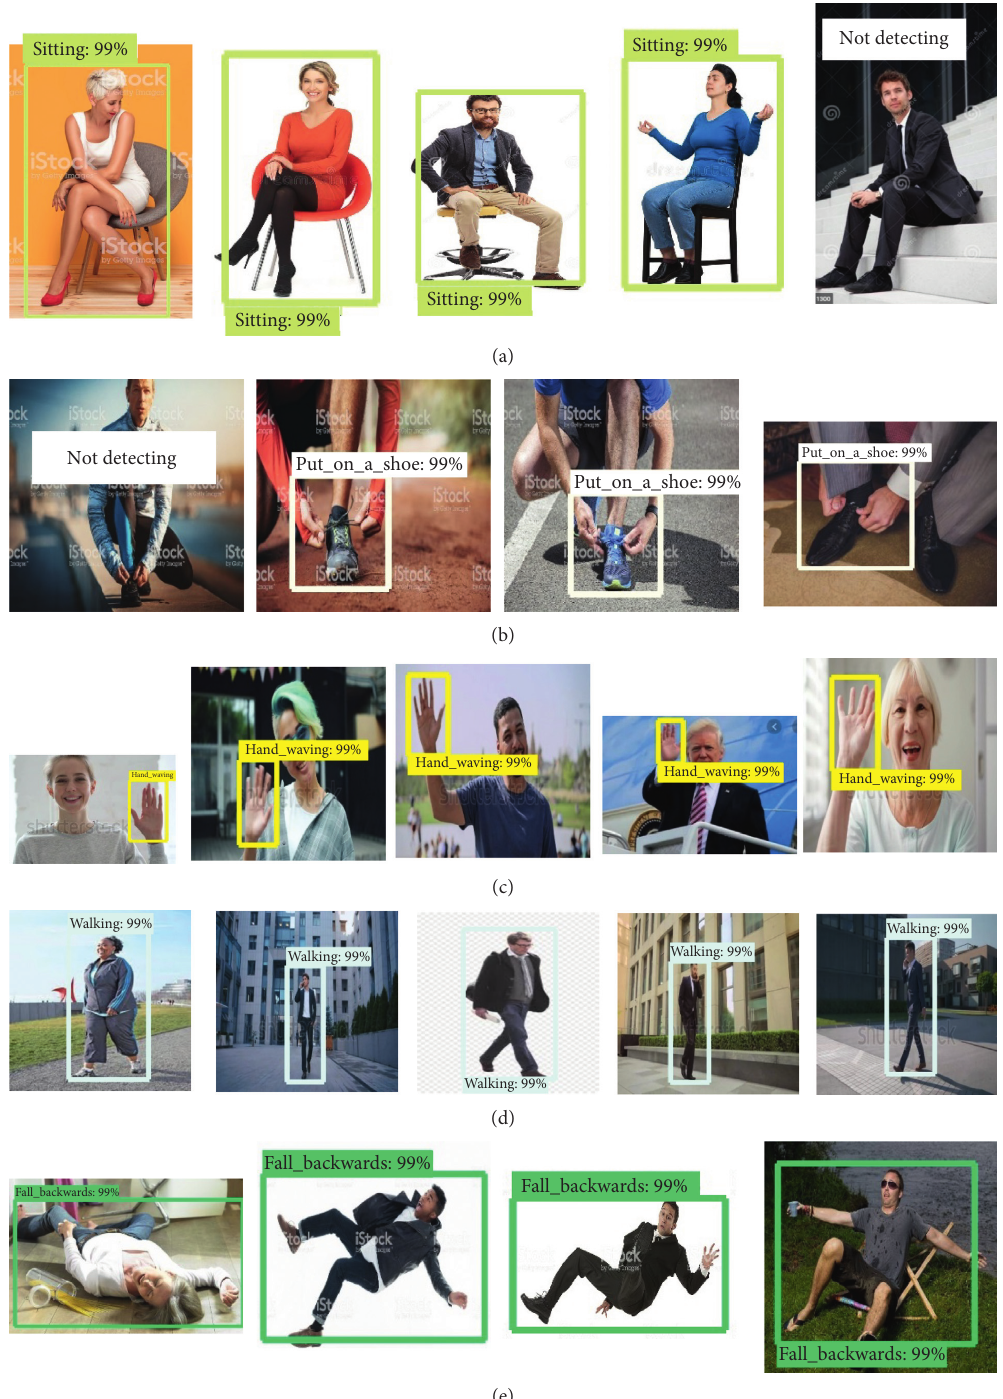
Figure 18: Training results with Tensorflow (RFCN +Resnet101) for (a) sitting down, (b) wearing shoes, (c) waving hands, (d) walking, and (e) falling